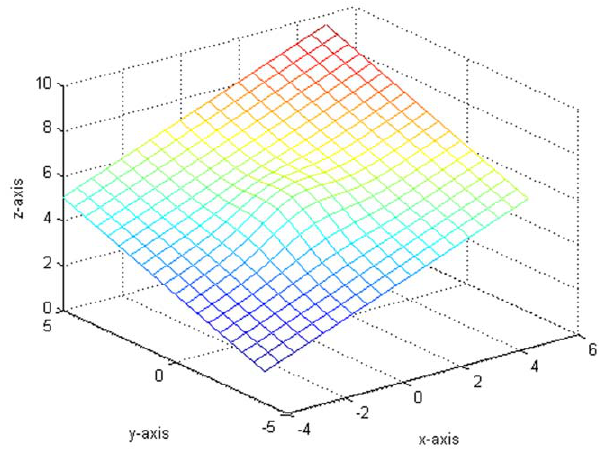
Figure 18. The plot of drawing fitted plot and original plot together.